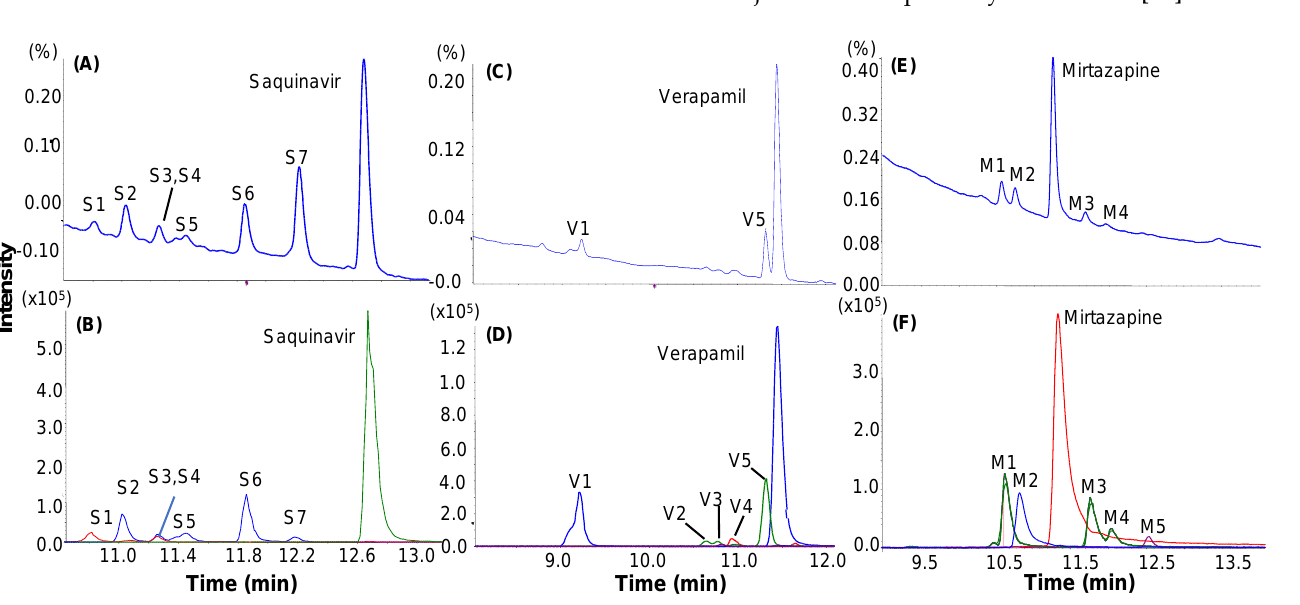
Figure 3. Metabolic soft-spot identification of saquinavir, verapamil, and mirtazapine metabolites in HLM using LC/UV/Q-TOF. ( A ) LC/UV profile of the saquinavir incubation sample (5 µM, 4 min). S6, and S7 had relatively higher abundances and were determined as major metabolites; ( B ) EIC of saquinavir metabolites were found by data-mining; ( C ) LC/UV profile of the verapamil incubation sample (5 µM, 8 min). V1 and V5 were determined as major metabolites; ( D ) EIC of verapamil metabolites were found by data-mining. ( E ) LC/UV profile of the mirtazapine incubation sample (3 µM, 60 min). M1 and M2 were determined as major metabolites; ( F ) EIC of mirtazapine metabolites were found by data-mining.